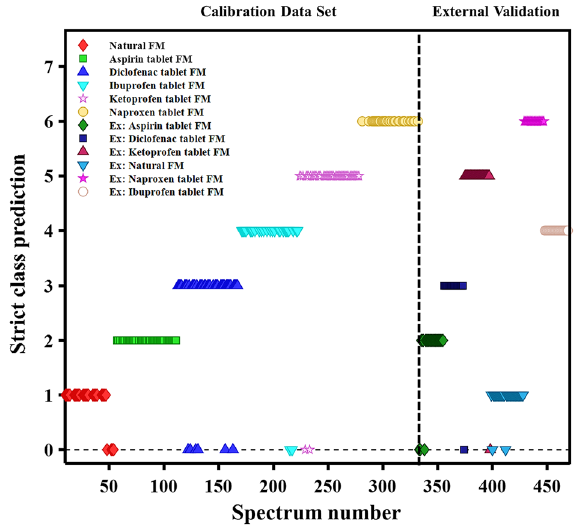
Figure 4. Strict prediction results of the PLS-DA classification model for natural FM- and NSAID- contaminated FMs based on five latent variables using regions selected by GA. The left side of the plot shows the calibration results based on the training dataset. The right side of the plot shows the external validation tests from an independent donor.